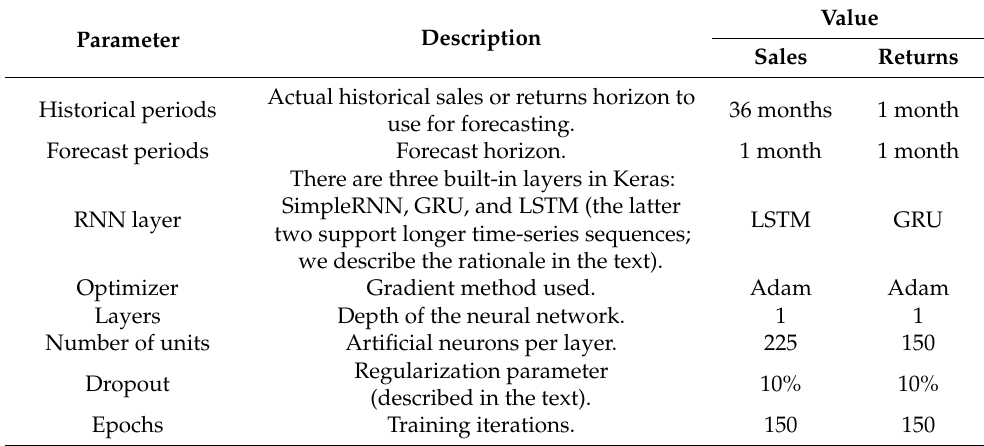
Table 1. RNN model parameters.